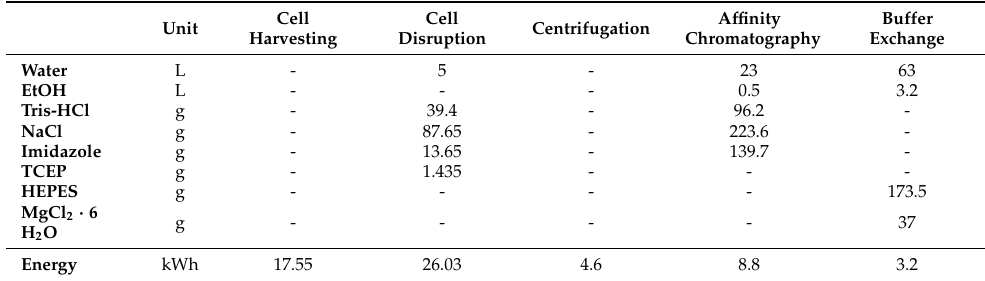
Table A2. Detailed list of all chemicals and energy quantities required during enzyme